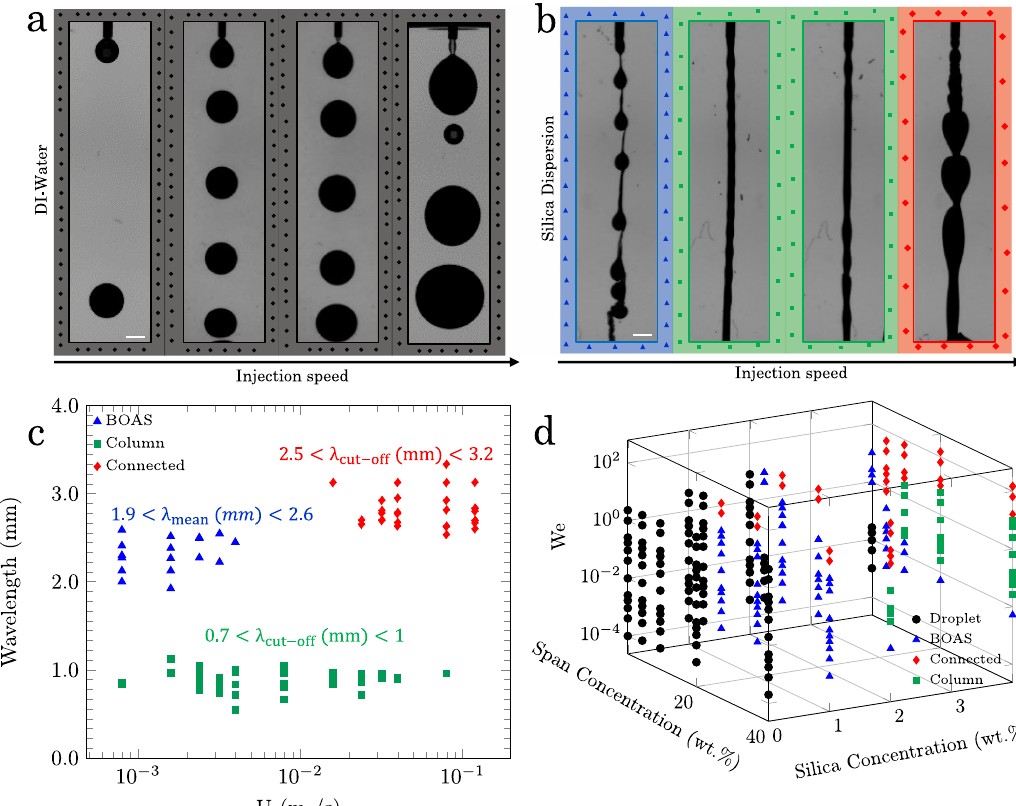
Fig. 1 Flow regime morphologies. a DI water and b 4.0 wt.% silica dispersion are injected into a 20.0 wt.% Span micellar solution. The scale bar is 1 mm. c A plot of the wavelength versus the fl ow rates identi fi es four morphologies as single droplet (black), BOAS (blue), liquid column (green), and connected droplet (red), as characterized based on a Fast Fourier Transform (FFT) analysis (Supplementary Notes 2 and 3). d Flow regime map of tested Span and silica concentrations at various injection fl ow rates, where the latter is represented using the Weber number. The map indicates the formation of liquid columns at We = O (0.01). Source data are provided as a Source Data fi